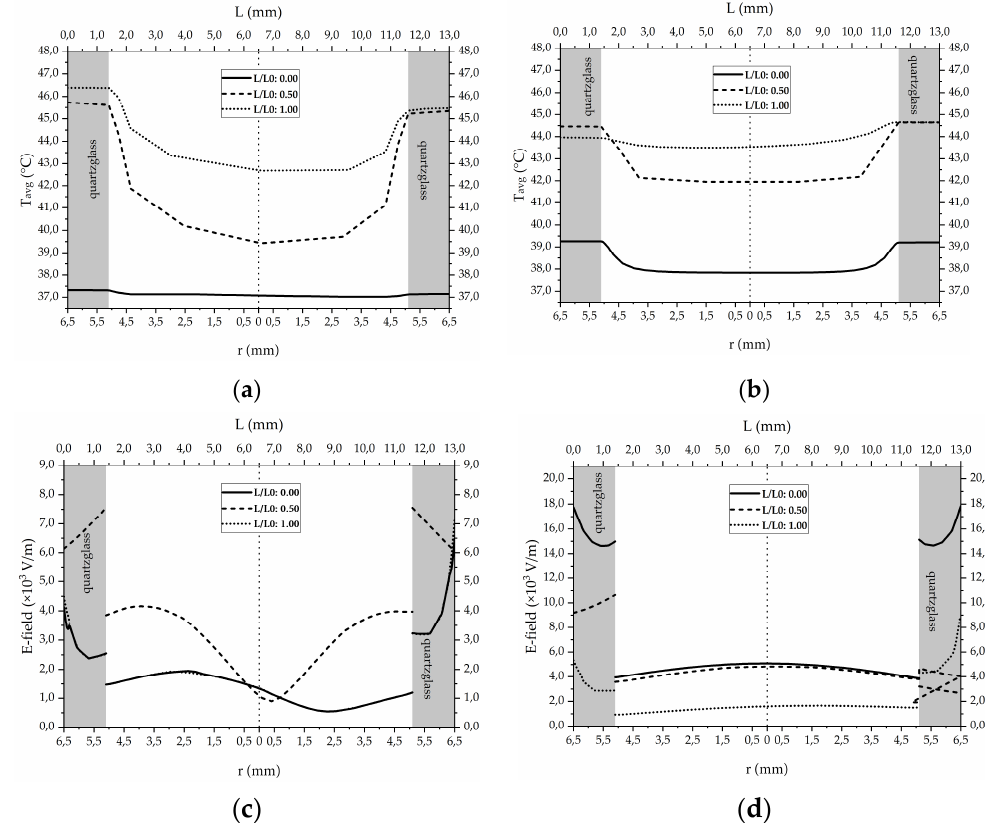
Figure 7. Simulated radial temperature profiles for ( a ) 2.45 GHz and ( b ) 915 MHz and simulated electric field distribution for ( c ) 2.45 GHz and ( d ) 915 MHz at the beginning, middle and end of the exposed tube piece. Process conditions in this example were T target = 44 °C and V m = 2 mL/s at P MW = 100 W at 2.45 GHz, or P MW = 500 W at 915 MHz, respectively. Additional information about the heating systems used for simulation and experiments is provided in Sections 2.1 and 2.2.